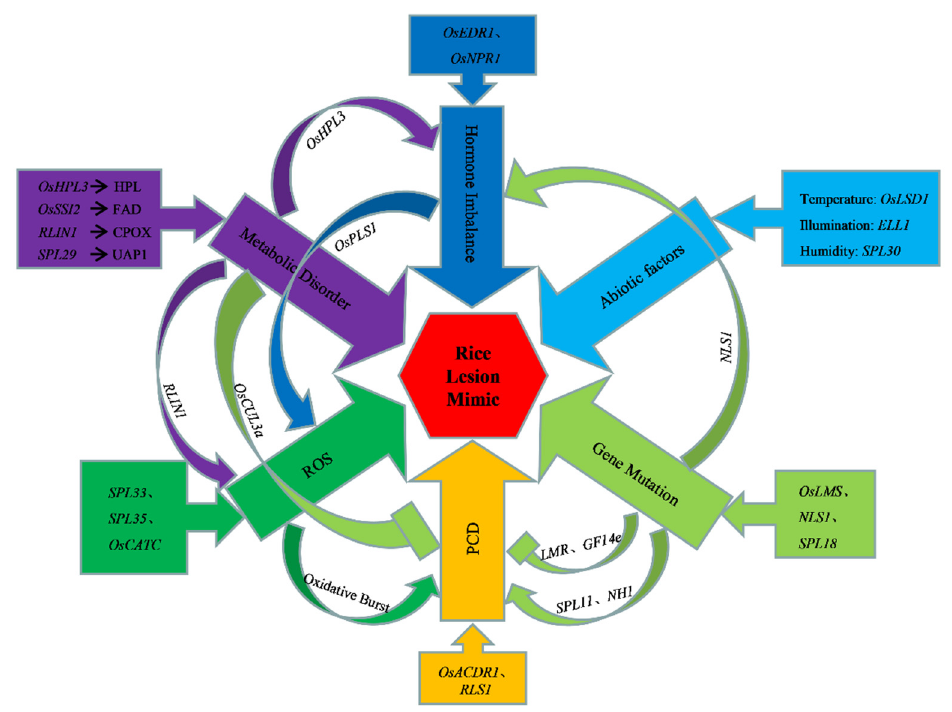
Figure 1. Mechanism of some rice lesion mimic mutations. PCD: Programmed Cell Death; ROS: Reactive Oxygen Species; HPL, Hydroperoxide Lyase; FAD, Fatty Acid Desaturase; UAP1, Uridinedipho Acetylglucosamine Pyrophosphorylase 1.